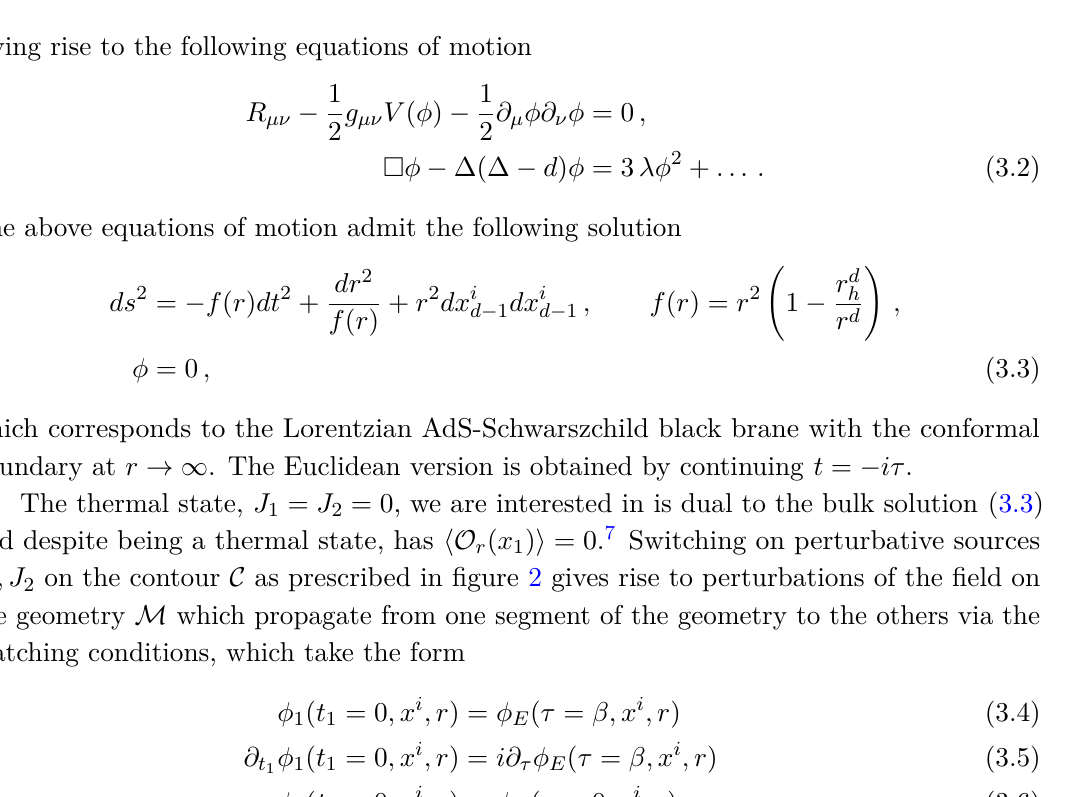
Figure 2 . The bulk geometry M dual to the Schwinger-Keldysh contour in figure 1. The Euclidean segment of the contour C E is filled in with a Euclidean black hole; topologically, this fills in the Euclidean time circle to give rise to a (cut) disk, M E . The two Lorentzian segments C 1 , C 2 fill in with two copies of a part of an eternal (Lorentzian) black hole, M 1 , M 2 . The fields are piecewise-smooth, and C 1 along the joins between